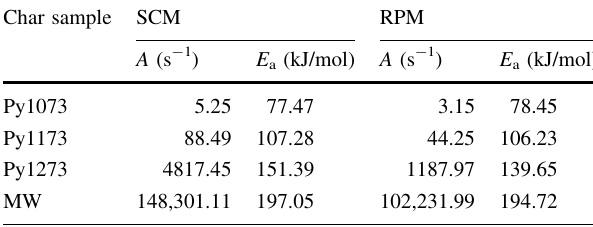
Fig. 4 Determination of the kinetic parameters ( A and E a ) from the SCM and RPM models: a Py1073 char; b Py1173 char; c Py1273 char; and d MW